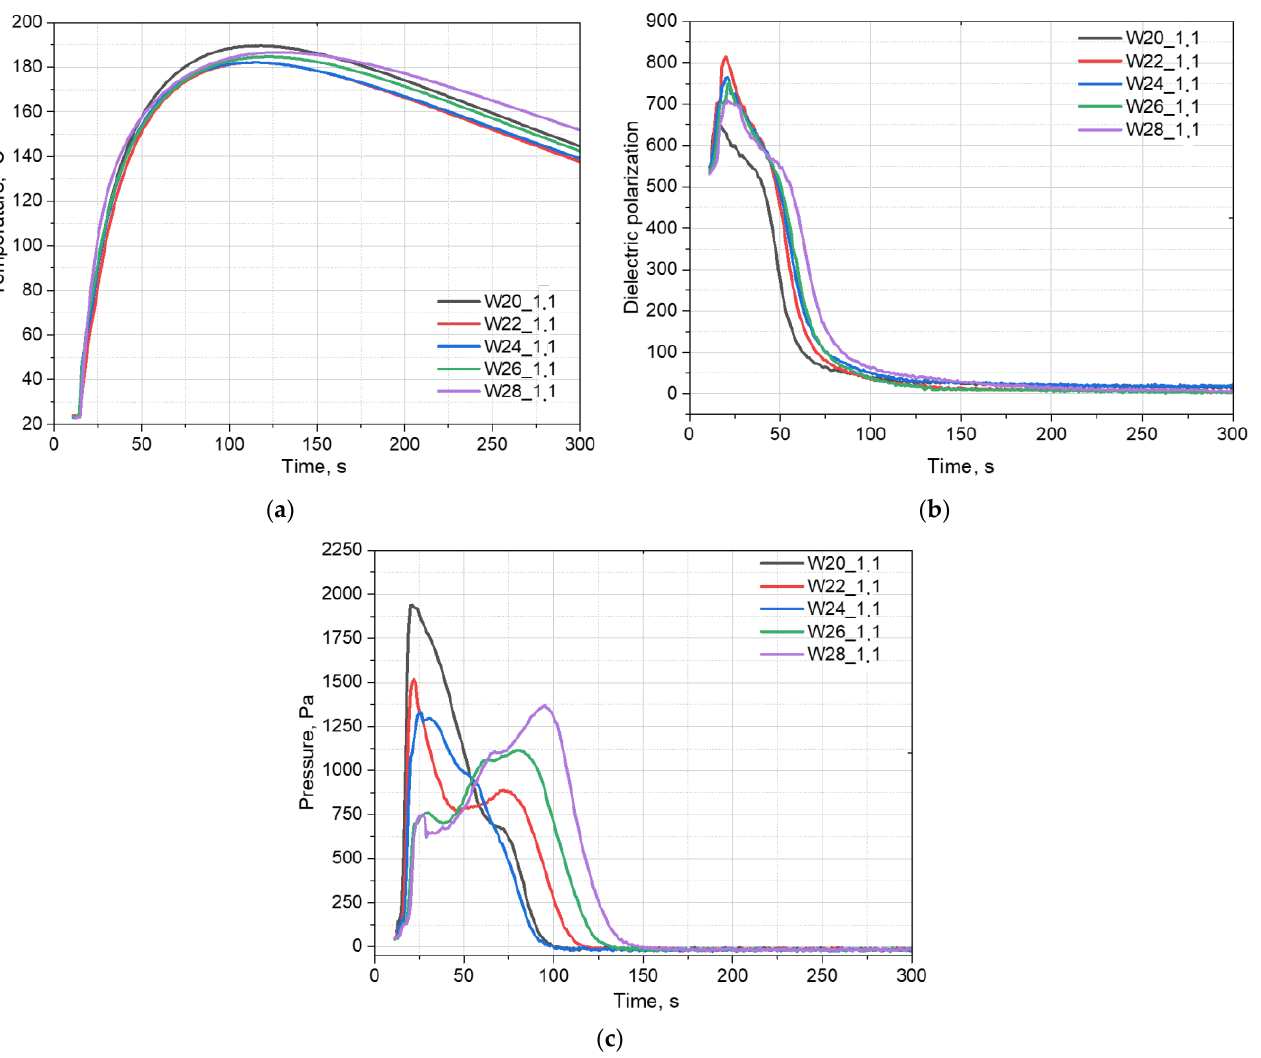
Figure 1. The influence of the water content on the system temperature ( a ), dielectric polarization ( b ), and pressure ( c ) during the foaming process. Dielectric polarization is a key parameter that gives an insight into electrochemical processes during the transition from a mixture of liquid components, such as polyol, isocyanate, and additives, to the final PU foam. Polyols and isocyanates are characterized by a strong dipole moment, unlike the resulting PUs [13]. The observation of the curves corresponding to the change in dielectric polarization during polyurethane formation shows that increasing the amount of water in the PU system reduced the rate of the reactions taking place (Figure 1b). The more water in the system, the slower the dielectric polarization value